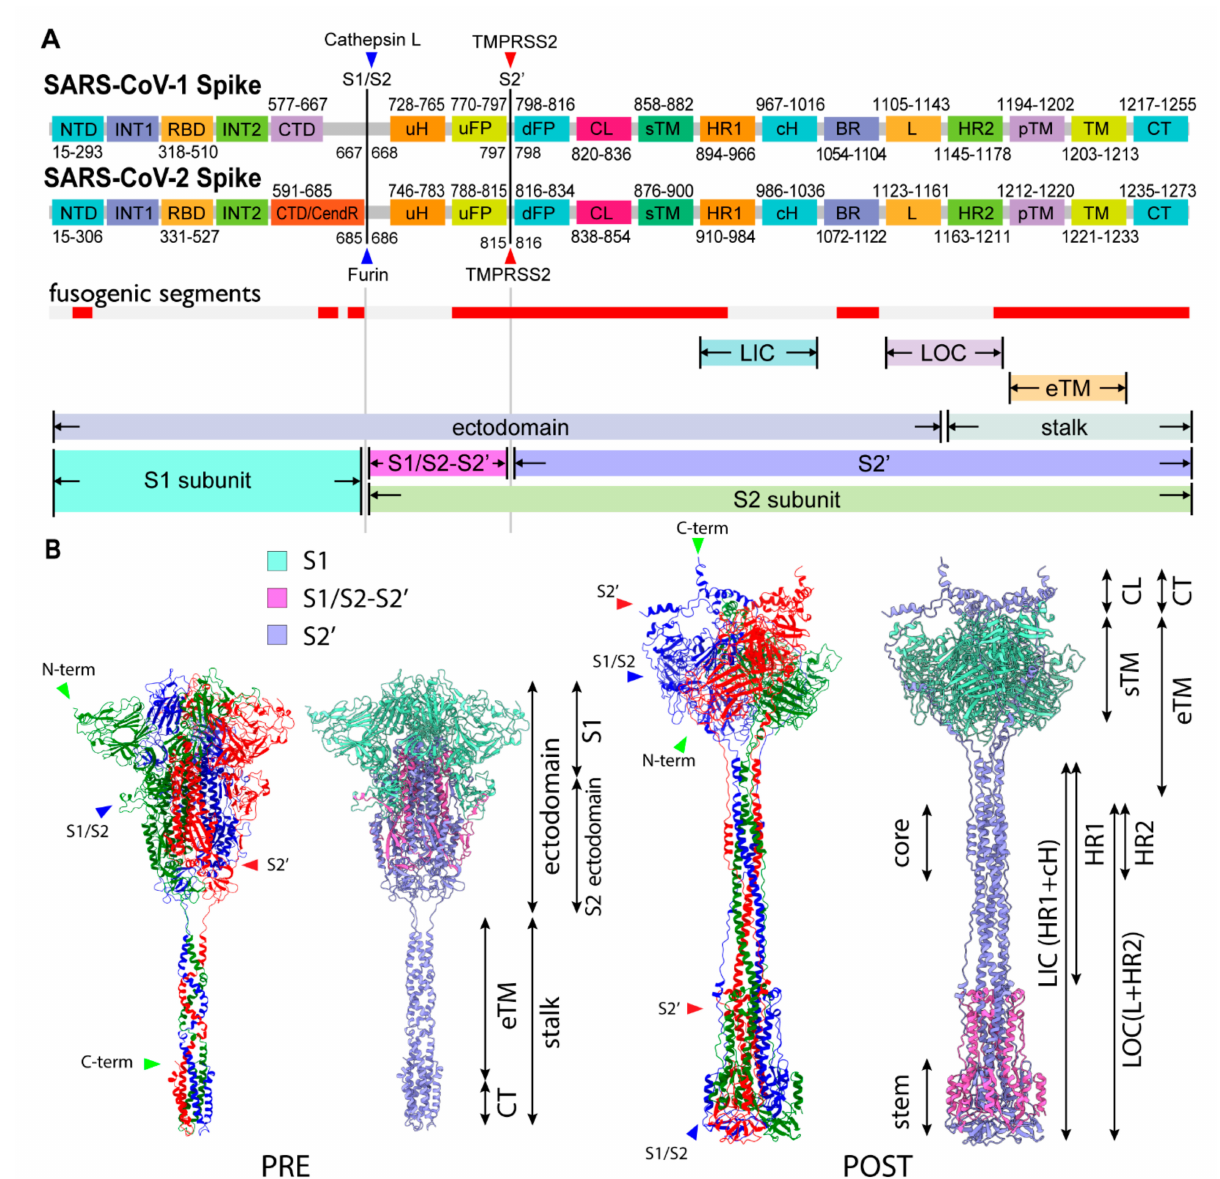
Figure 1. Functional fragments and structural overview of spike protein for SARS-CoV-1/2. ( A ) Schematic segments of S1 and S2 subunits and corresponding residues for SARS-CoV-1/2 (NTD: N-terminal domain; RBD: receptor binding domain; INT1/2: internal sub domain1/2; CTD: C-terminal domain; CendR: multibasic motif; uH: upstream helix; uFP: upstream fusion peptide; dFP: downstream fusion peptide (aka. FP + FPPR); CL: cytoplasmic loop; sTM: sub-transmembrane; HR1: heptad repeat 1; cH: central helix; BR: β -rich region; L: linker; HR2: heptad repeat 2; pTM: pre-transmembrane; TM: transmembrane; CT: cytoplasmic tail). Fusogenic segments are shown in the red bar (Table S2 for details), as well as larger regions of multiple segments (LIC: long inner core = HR1 + cH; LOC: long outer core = L + HR2; eTM: extended transmembrane = pTM + TM). ( B ) Structural overview of PRE and POST states (left: RGB colors indicate each monomer; right: light cyan, light magenta, light blue indicate S1, S1/S2-S2 (cid:48) , S2 (cid:48) subunits,